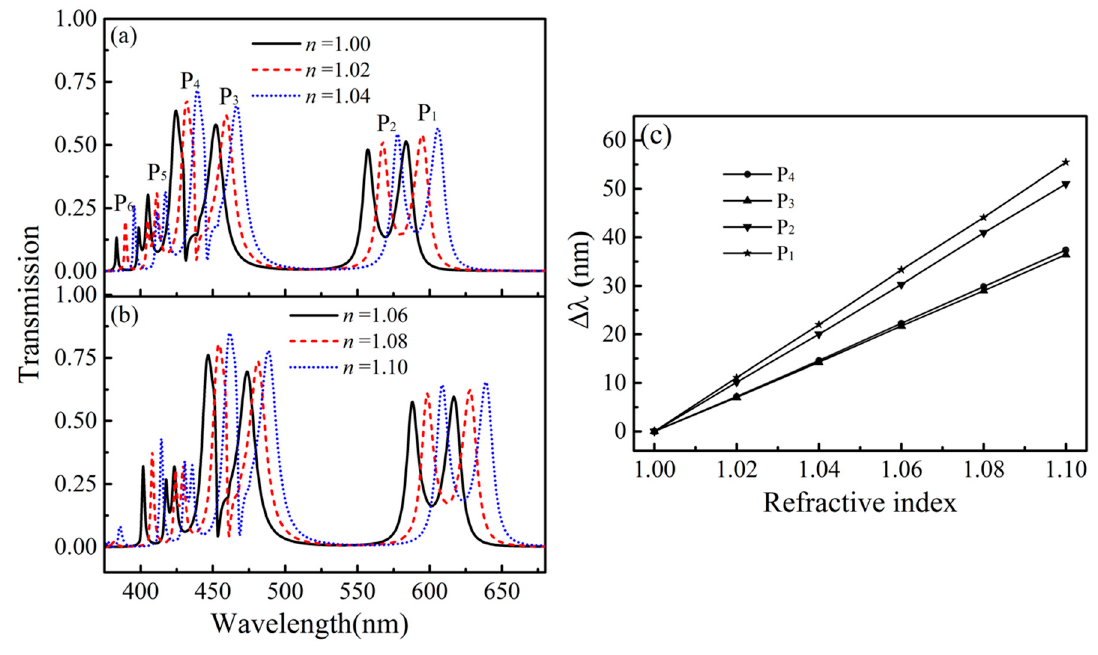
Figure 6. ( a ) Transmission changes for different refractive indexes n = 1.0, 1.02, 1.04; and ( b ) n = 1.06, 1.08, 1.10; ( c ) Corresponding wavelength changes of the resonance peaks for different refractive indexes.